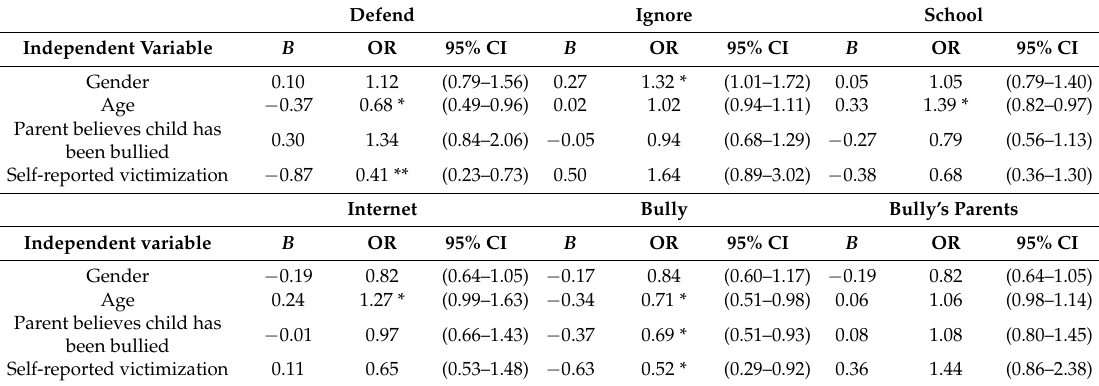
Table 6. Logistic regression model predicting the associations among the parents’ responses, gender, age, the parent’s awareness of bullying involvement, and self-reported victimization. OR: odds ratio.